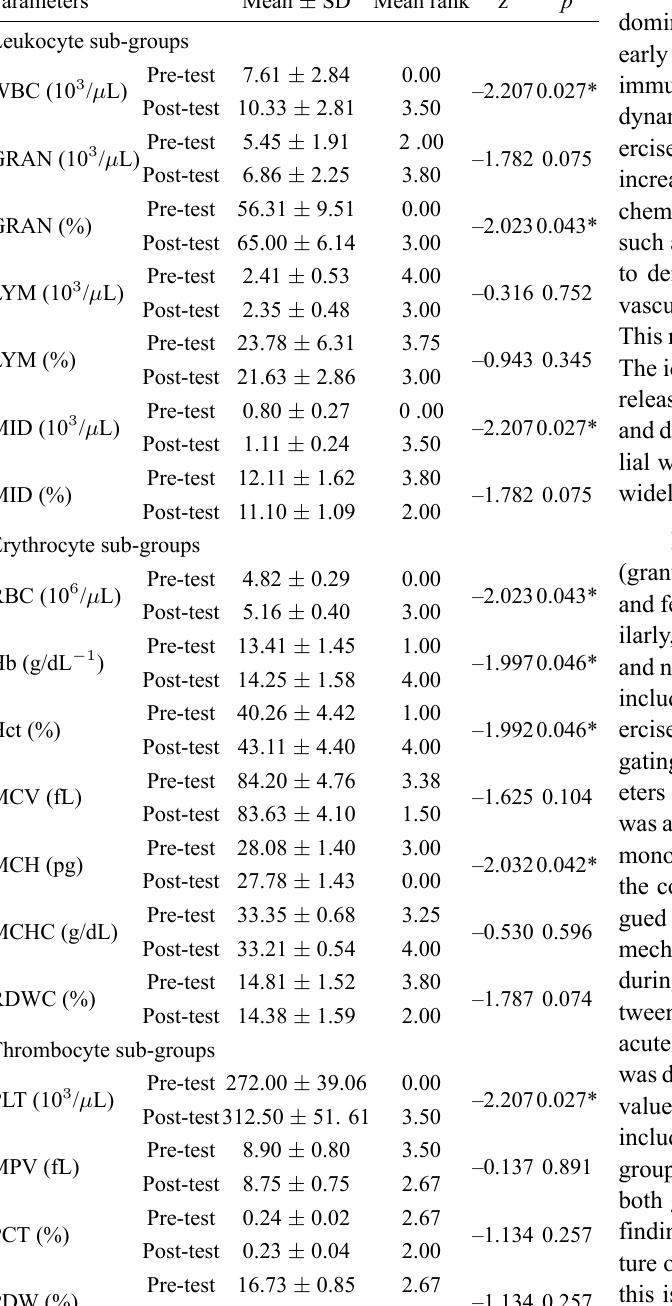
Table 3. Hematological parameter changes before and after the acute moderate-intensity training in female athletes (mean ± standard deviation) (n =